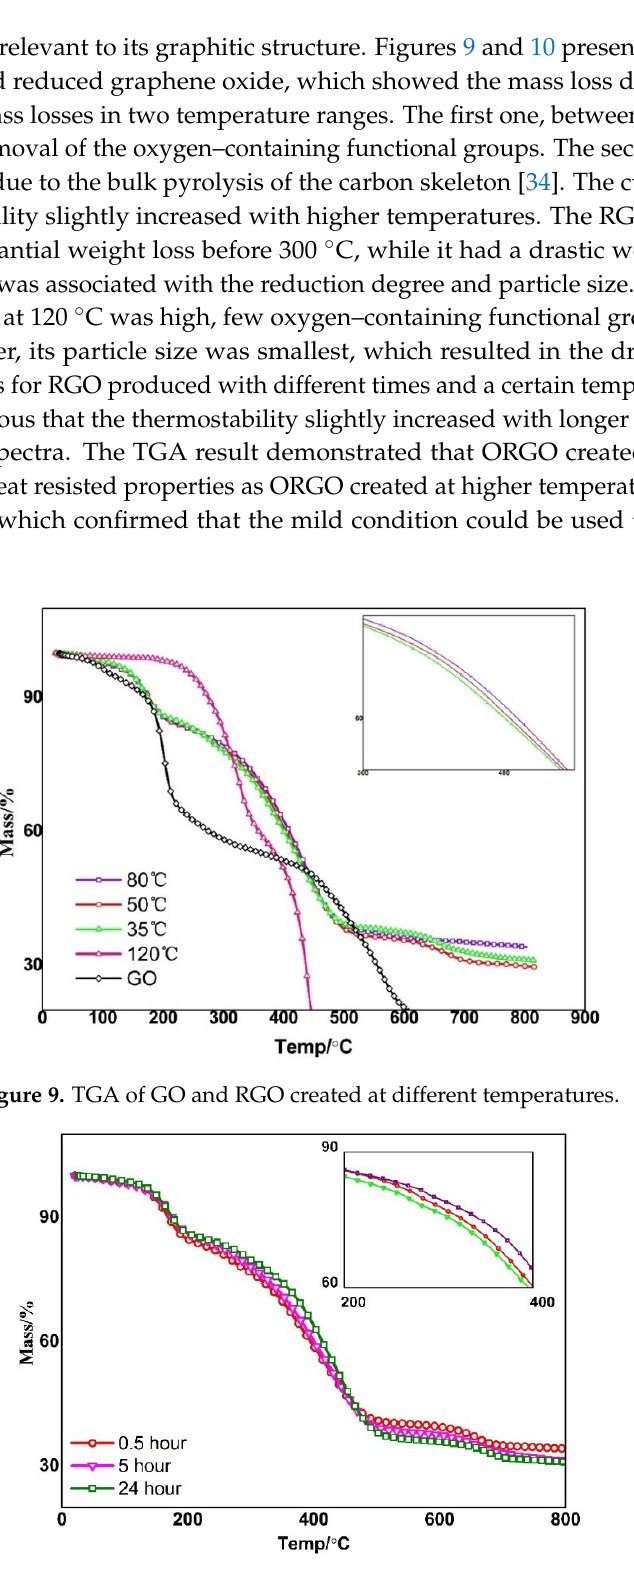
Figure 10. TGA of RGO created with different reaction times.